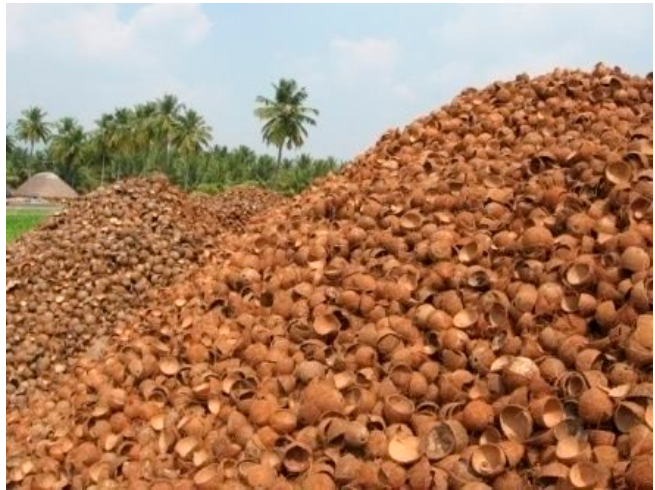
Figure 2. The discarded coconut shells.